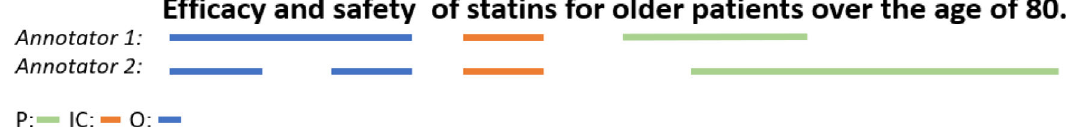
Figure 13. Example of inter-annotator disagreement. P, population; I, intervention; C, comparison; O,